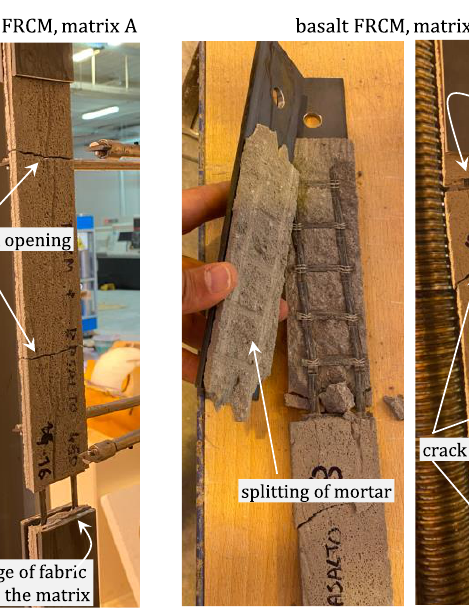
Figure 10. Failure mechanisms of basalt FRCM coupons realized with different cement-based ma- trices.